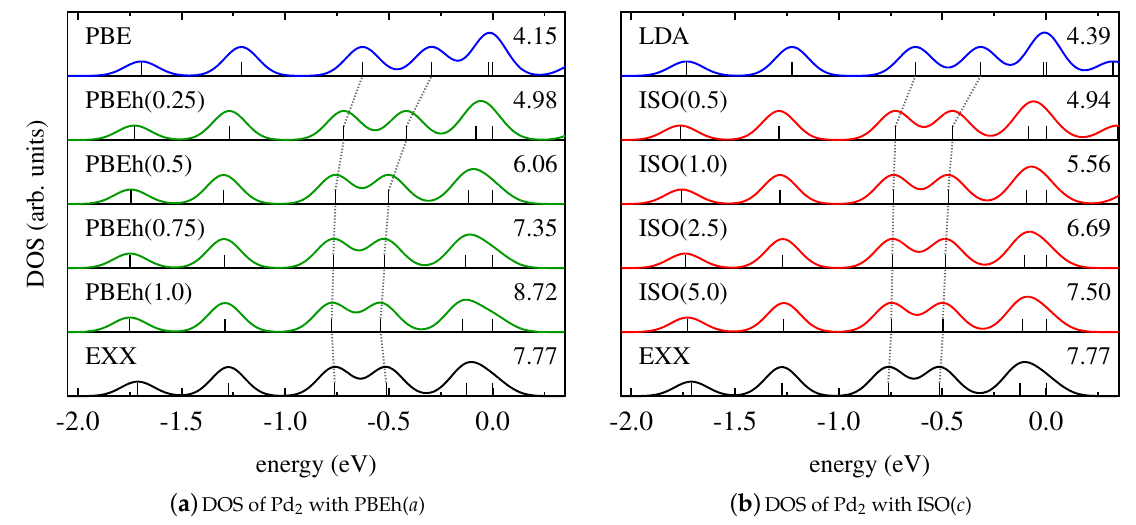
Figure 4. Kohn–Sham DOS of Pd 2 obtained with ( a ) PBE (blue), EXX (black), and PBEh in dependence on a (green); ( b ) LDA (blue), EXX (black), and ISO in dependence on c